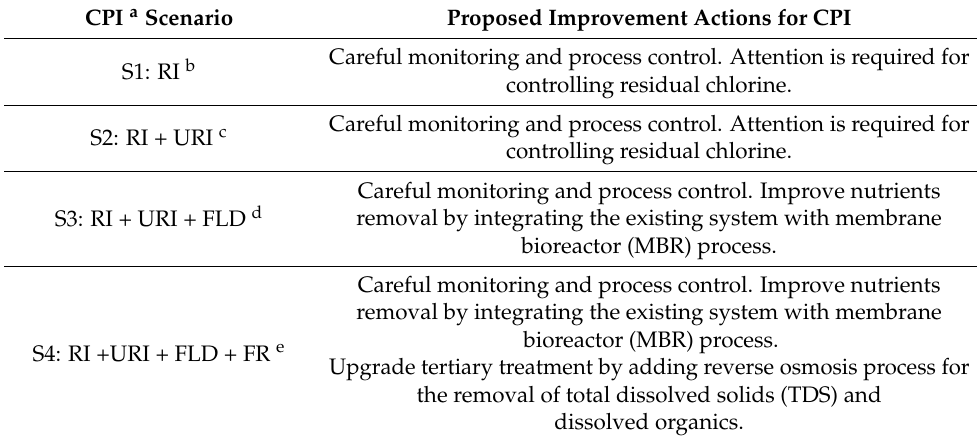
Table 9. Proposed improvement actions for continuous performance improvement (CPI) of